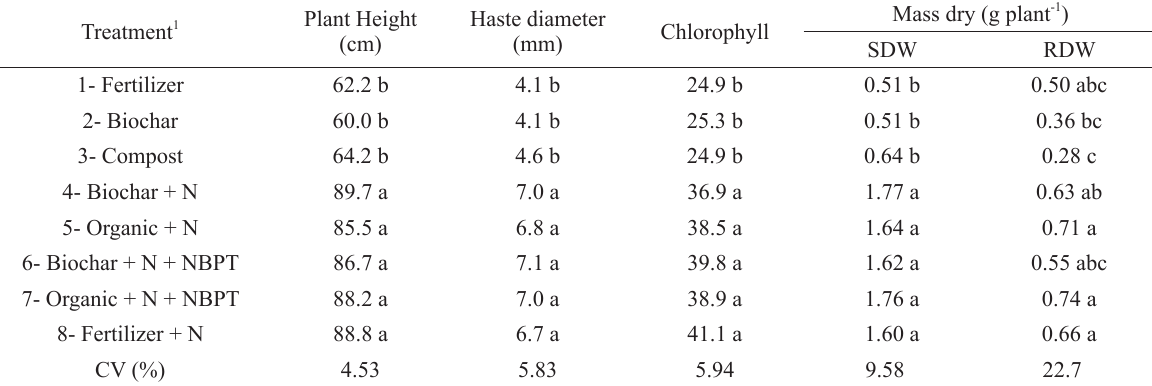
Maize physiological response to the fertilizer, compost and biochar applications and the combination with urea and